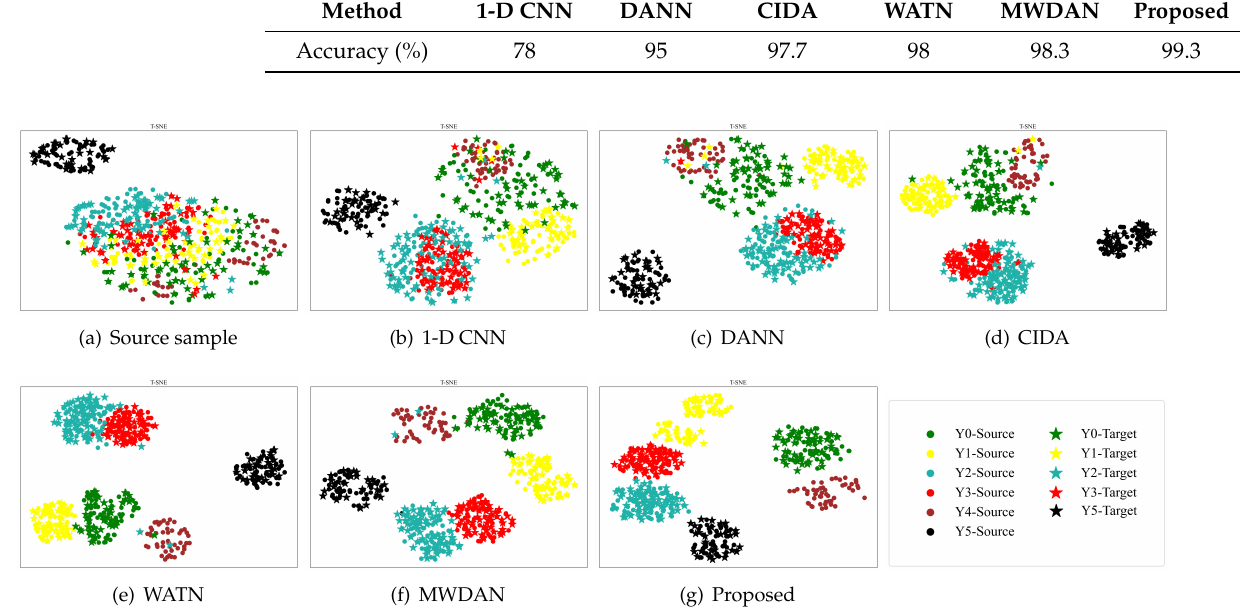
Figure 15. T-SNE feature